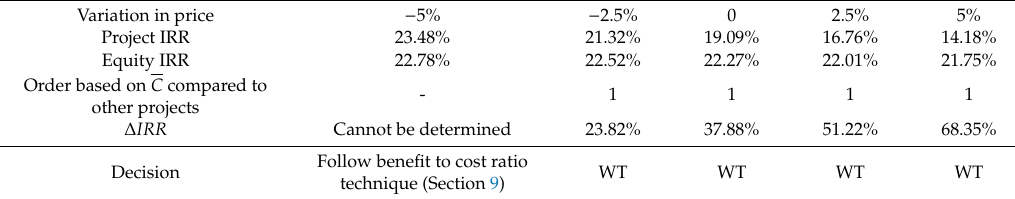
Table 6. 1 MW diesel cost variation e ff ect on IRR and